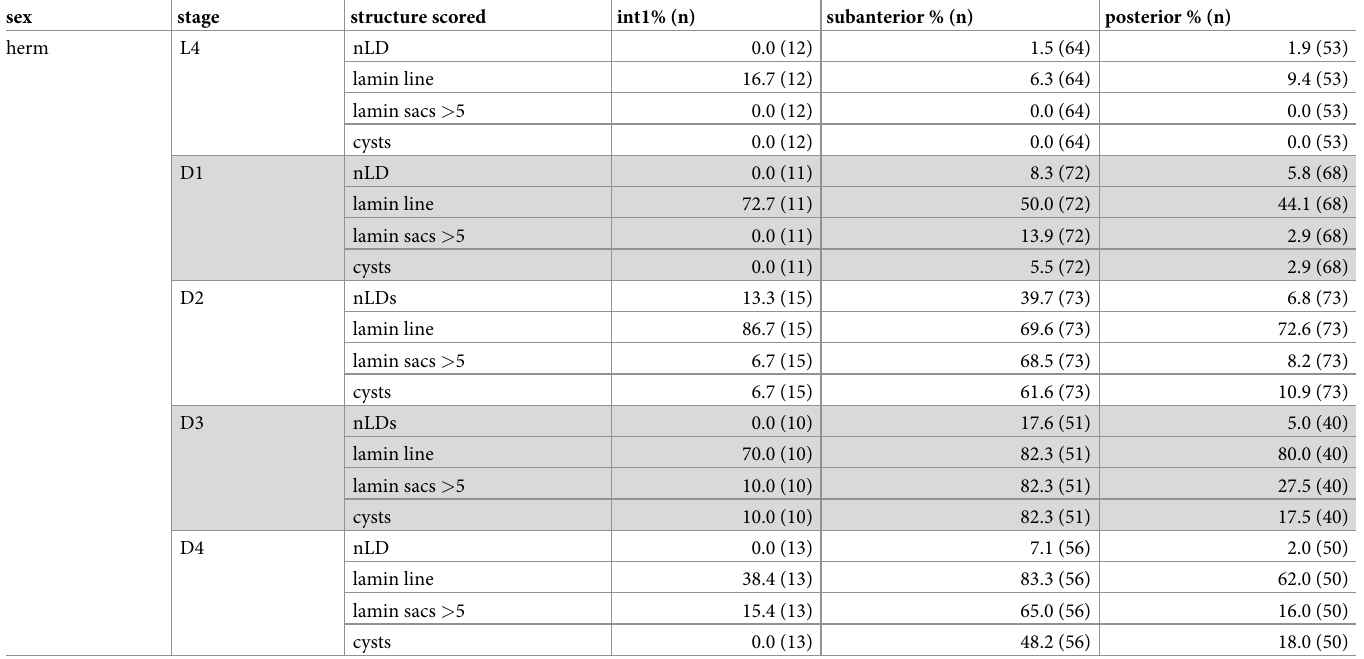
Table 2. Structures in intestinal